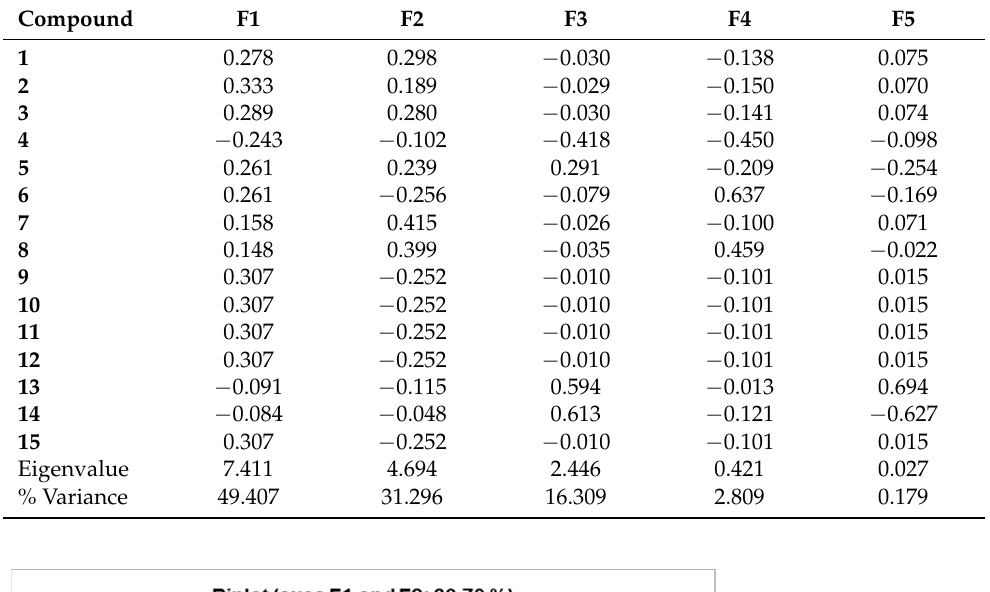
Table 2. Loadings, eigenvalues, and percentage of variance for the principal components (PCs) data from symbionts.